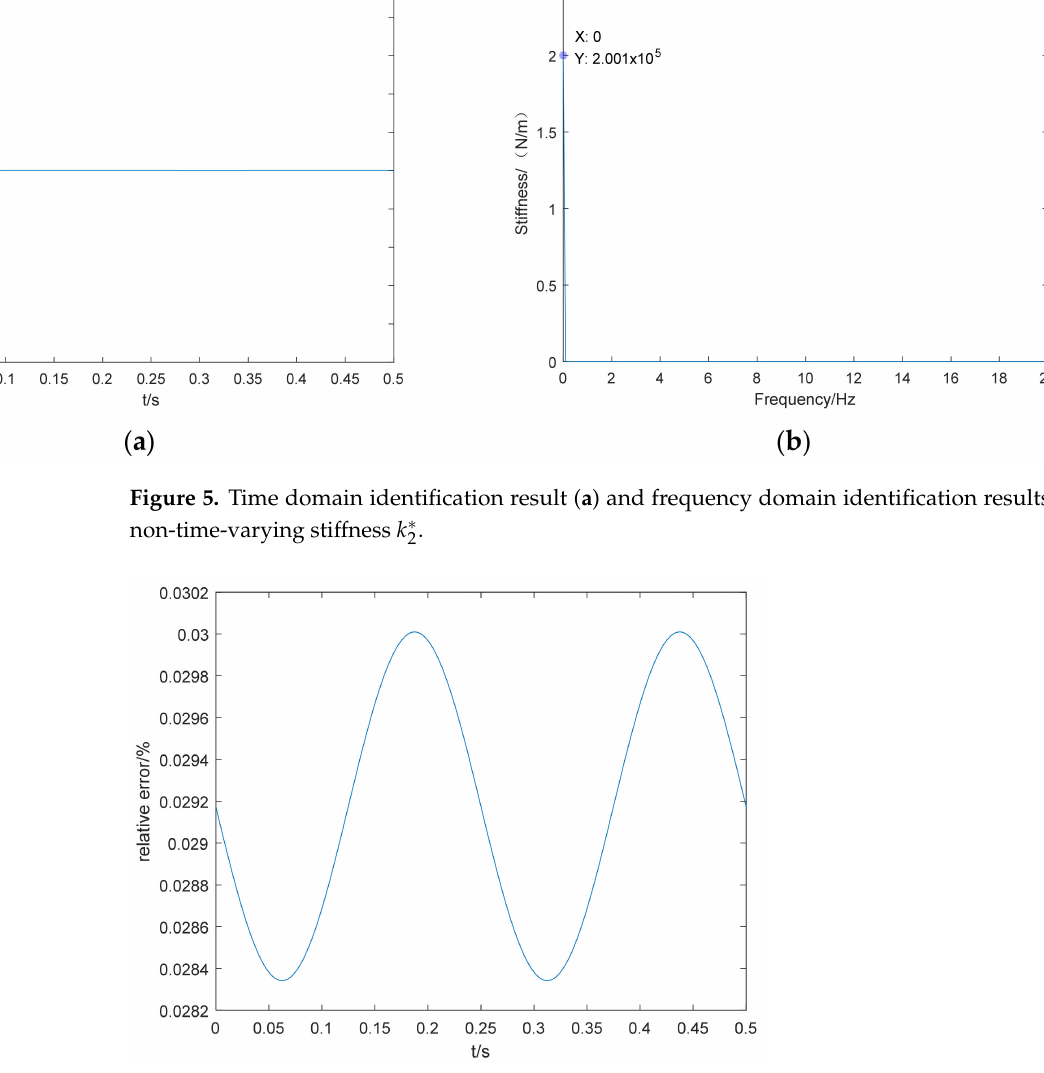
identification 2